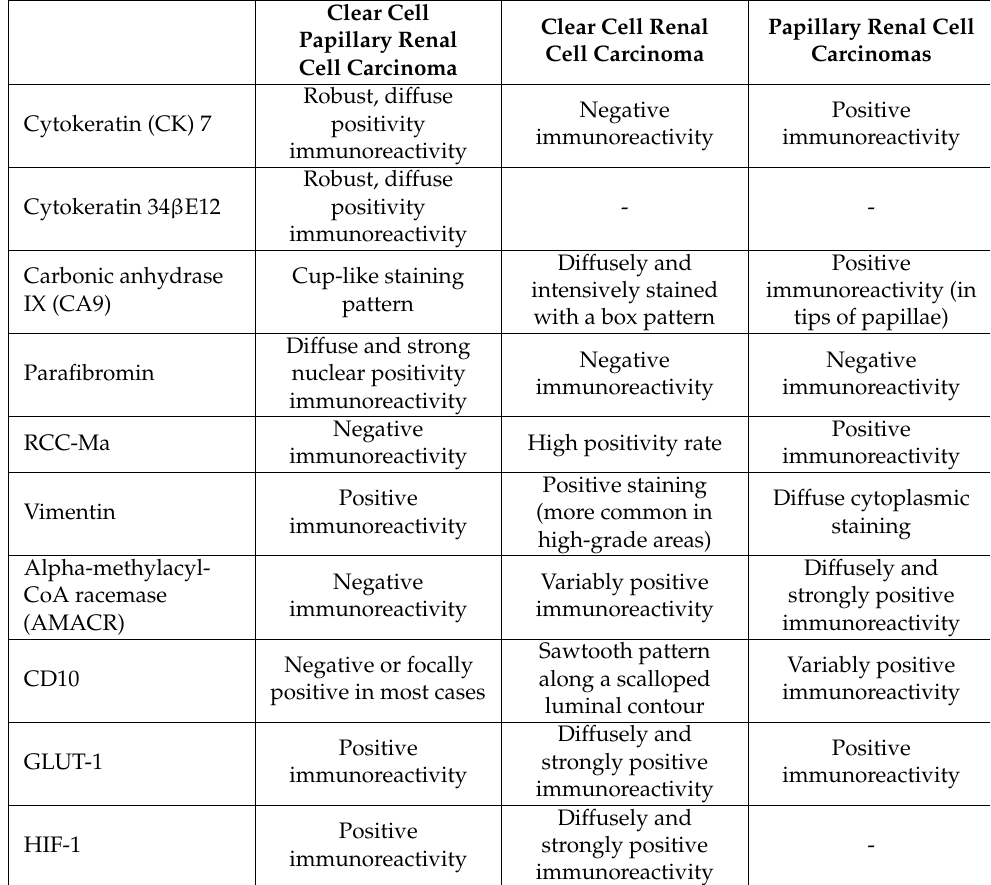
Table 2. The comparison of immunohistochemistry markers between ccpRCC, ccRCC, and pRCC.